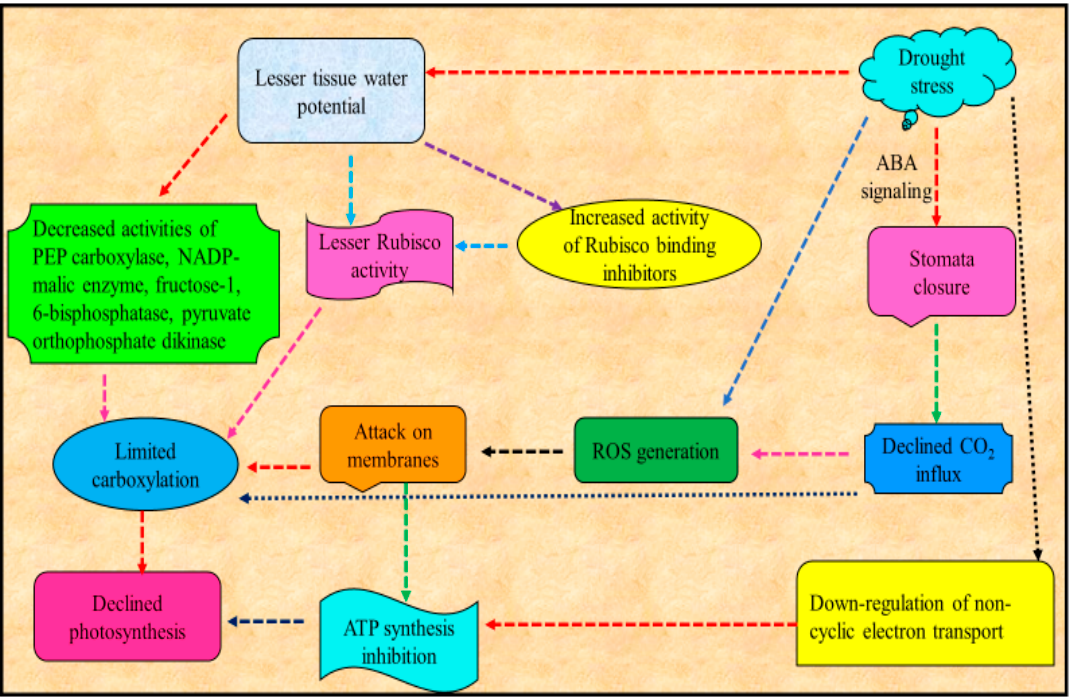
Figure 2. Schematic representation of effect of drought stress on photosynthesis (modified from Farooq et al. [17] ).